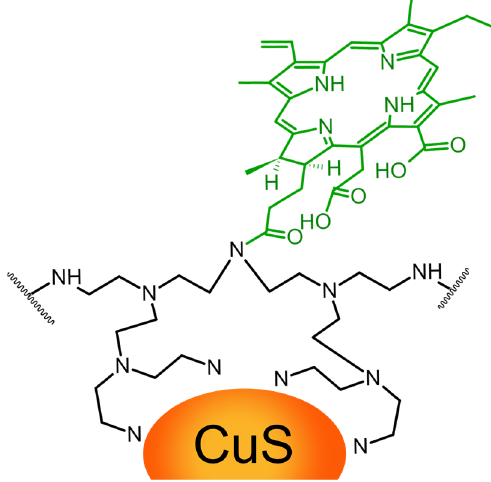
Figure 8. Chemical structure of the CuS nanoparticle (orange) surfaces, which were modified with polyethyleneimine (black) and Ce6 (green) [50].